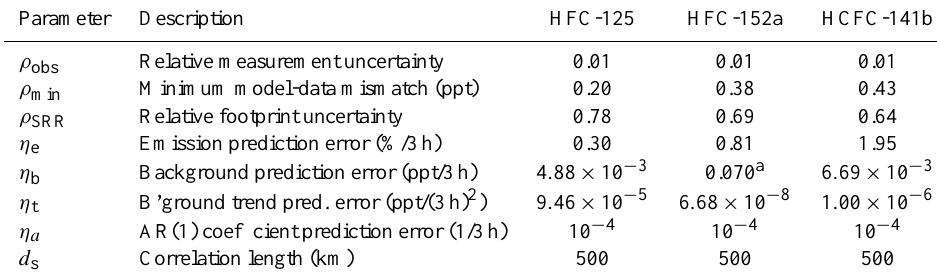
Table 4. Optimized parameter settings for HFC-125, HFC-152a and HCFC-141b.